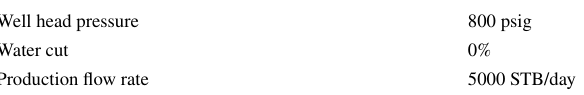
Table 7 Input parameters of two-phase correlation